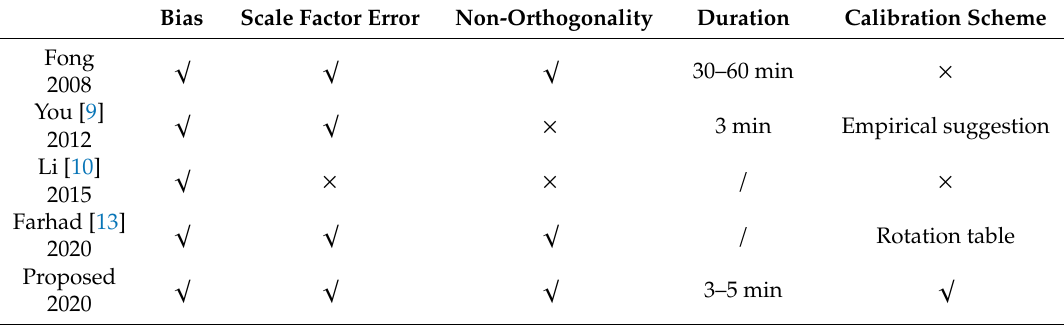
Table 1. Di ff erence between Proposed Algorithm and Related Work.